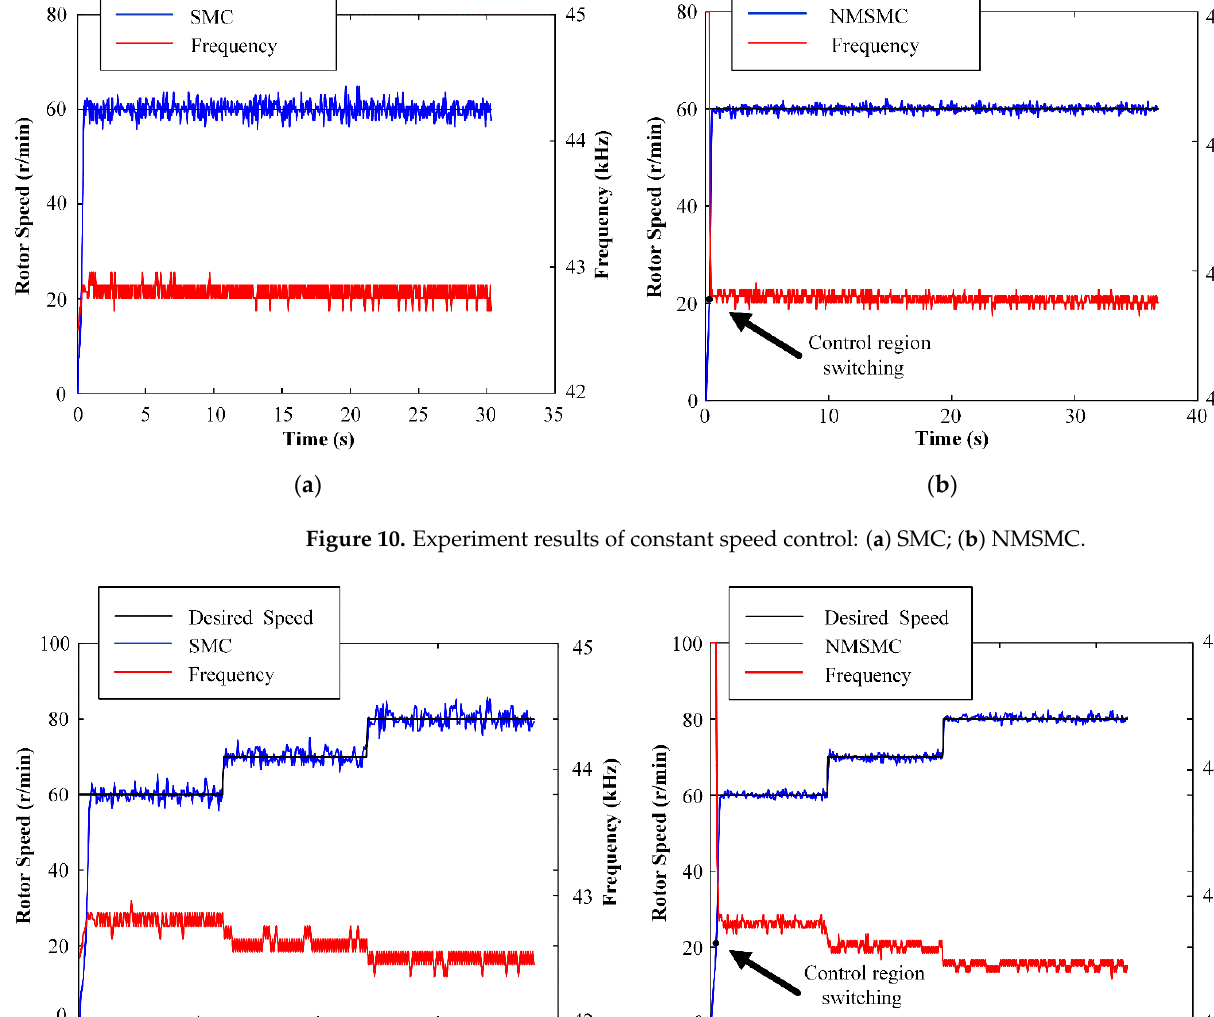
Figure 11. Experiment results of variable speed control: ( a ) SMC; ( b ) NMSMC.